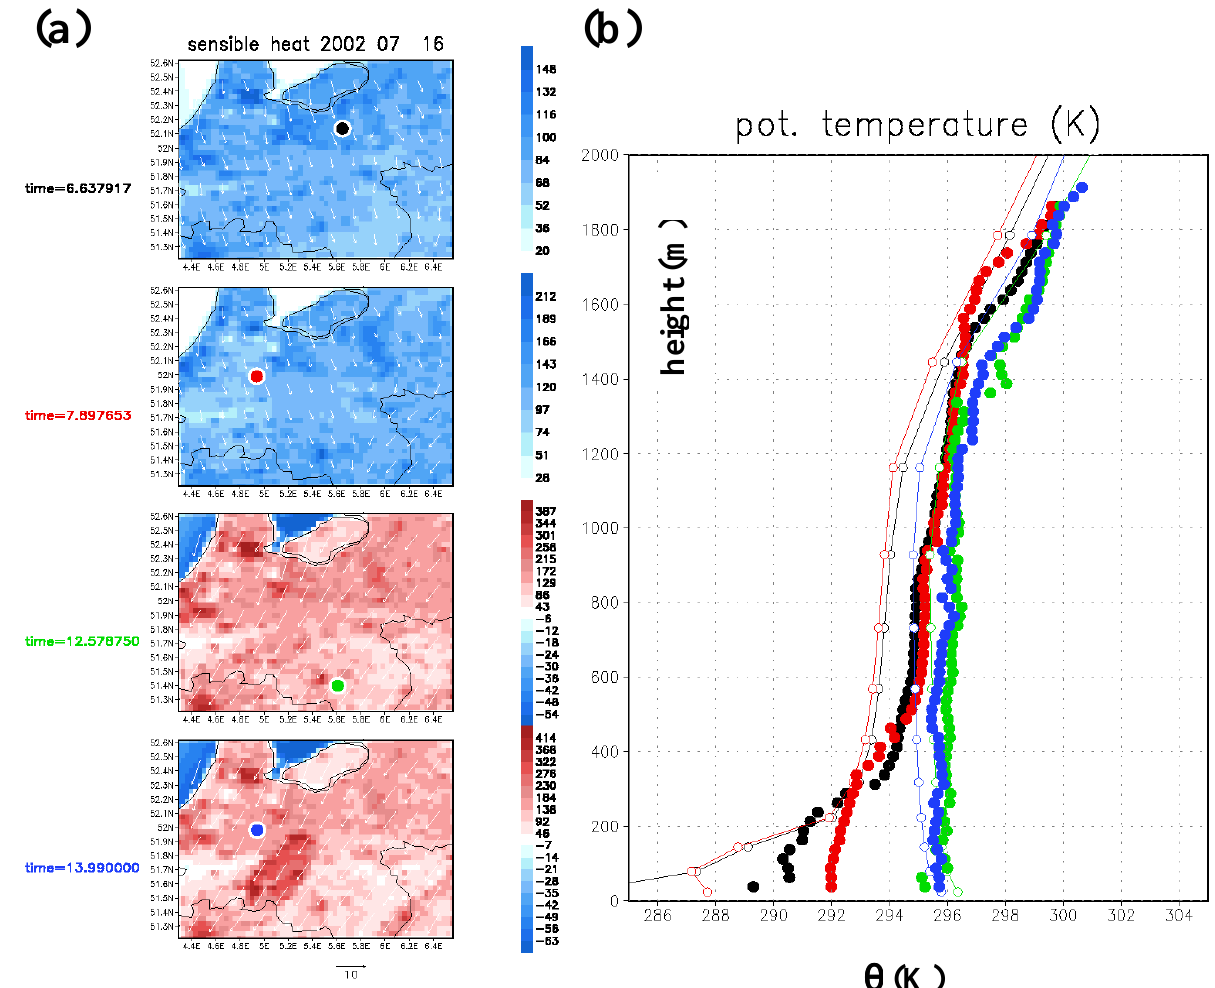
Fig. 13. Comparison of simulated profiles of potential temperature (K) against aircraft observations. (a) Simulated surface sensible heat flux field at time of profile flight, with profile flight locations (coloured dots). (b) Observed profiles (filled dots) and simulated profiles (open circles and lines). Note that the time sequence of the profiles is black, red, green and